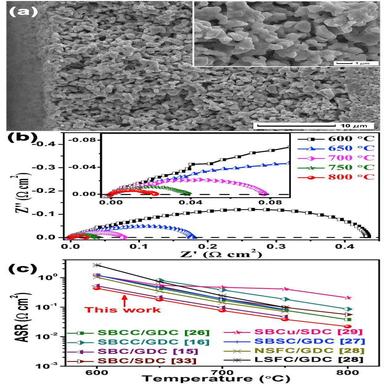
(a) SEM image of the SBCCC-based symmetrical cell. (b) Nyquist plots of the SBCCC/GDC/SBCCC symmetrical cell. (c) Temperature-dependence of the ASRs of the SBCCC cathode compared to reported ASR values for other related materials; SBCC, SBC, SBCu, SBSC, NSFC, and LSFC. GDC and Sm0.2Ce0.8O2-δ (SDC) are the electrolyte materials in the corresponding symmetrical cells.